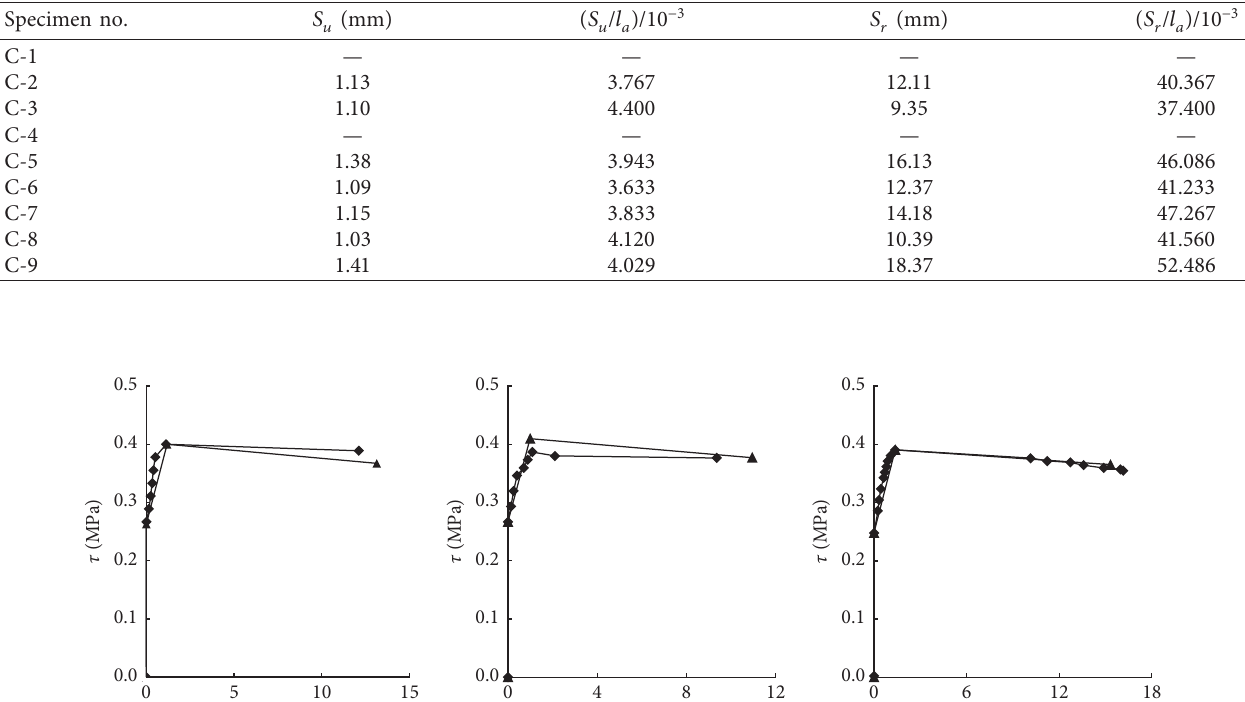
Table 4: Test results of characteristic slip